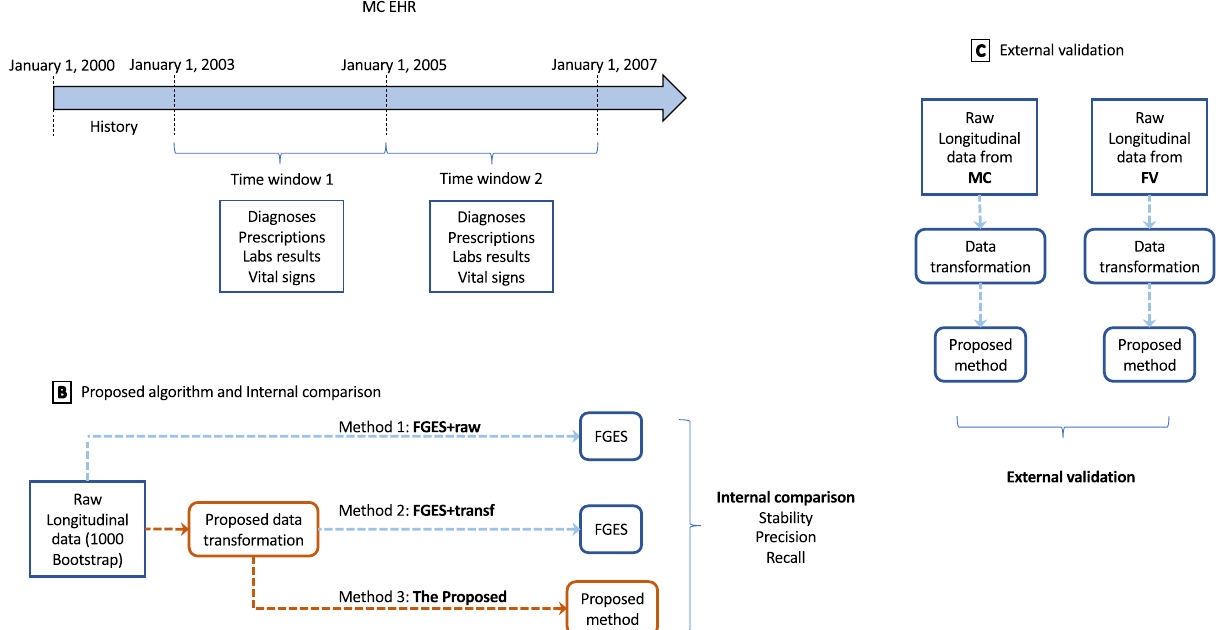
Figure 1. Study design and evaluations. ( A ) Overview of the study design for Mayo Clinic (MC) EHR. ( B ) The workflow of the internal evaluation. Three methods FGES + raw, FGES + transf, and the proposed algorithm were compared using stability, precision, and recall. Orange color highlights the proposed method (Method 3). ( C ) The workflow of external comparison. The proposed method was applied to two datasets, MC and M Health Fairview (FV), and the resulting graphs were